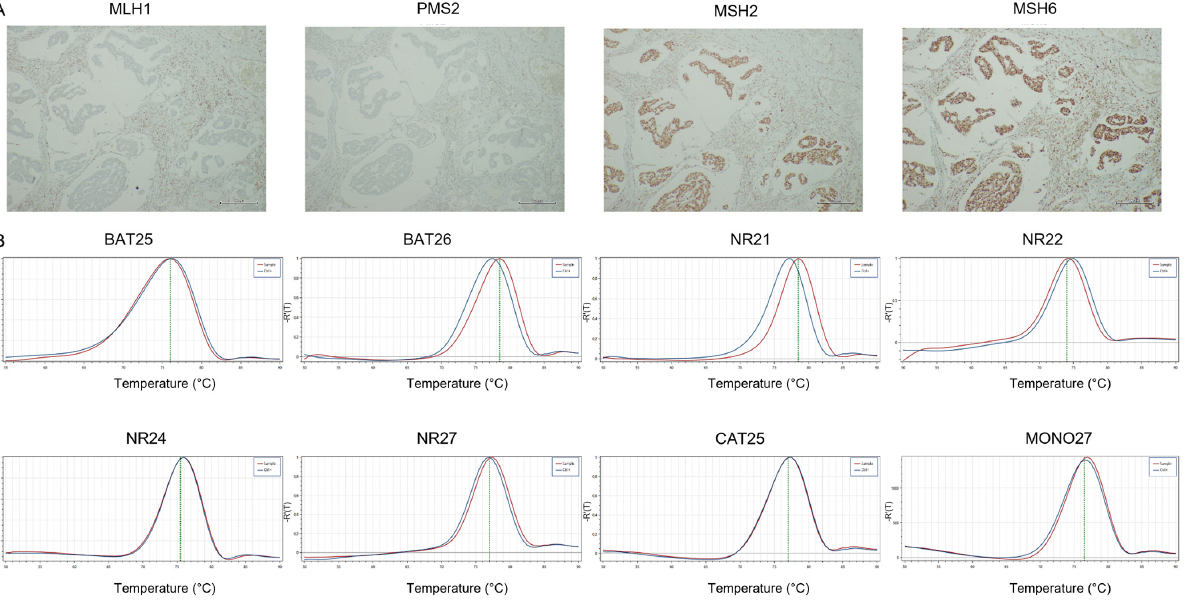
Figure 6. Representative results of GC case showing dMMR-IHC and MSS by PCR. ( A ) MMR-IHC results: loss expression of MLH1 and PMS2 in tumor cells with positive internal control (original magnification 10×); intact expression of MSH2 and MSH6 in tumor cells (original magnification 10×). ( B ) MSS-PCR results: stability of BAT25, BAT26, NR21, NR22, NR24, NR27, CAT25 and MONO27 (red lines indicate samples while blue lines indicate MSS controls).